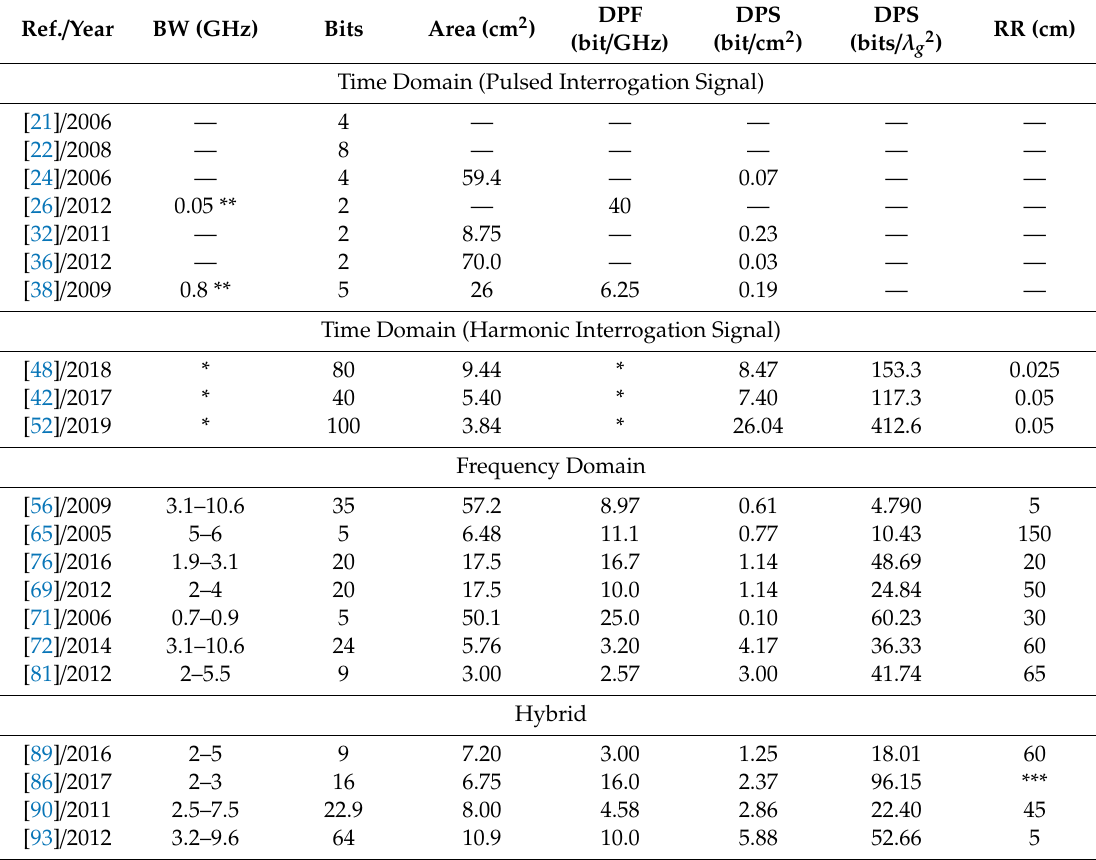
Table 1. Comparative analysis between encoding